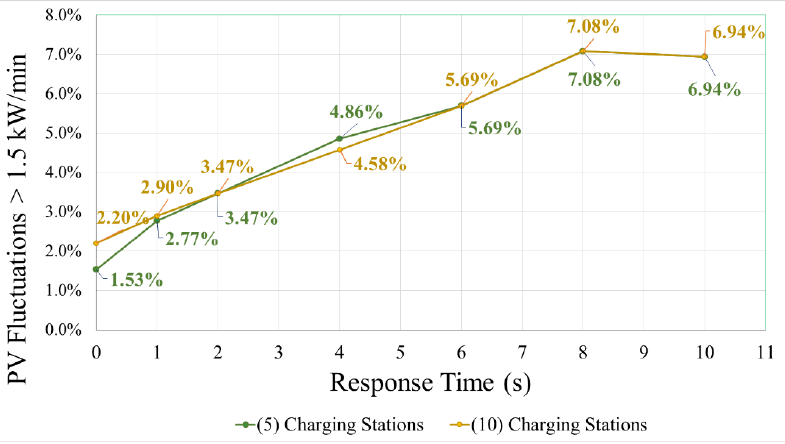
Figure 8. Response time, photovoltaic power fluctuations, and number of charging stations.